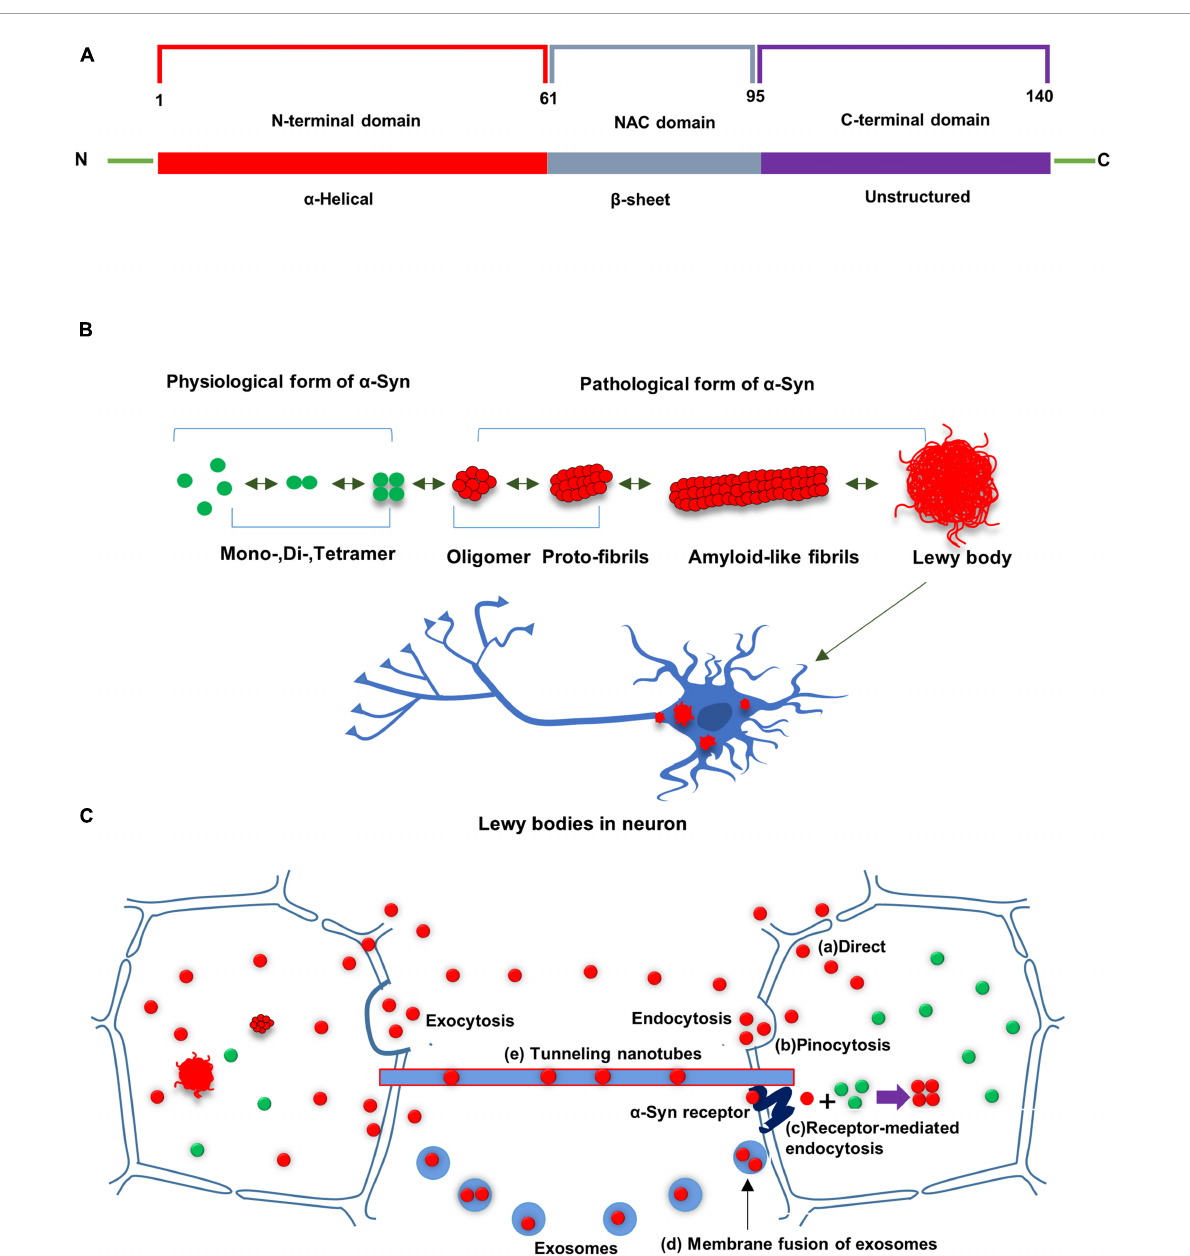
FIGURE1 (A) Schematic diagram of α -Syn. α -Syn consists of three distinctive domains: N terminal domain, non-amyloid component domain (NAC), and C-terminal domain. (B) Native α -Syn exists in the form of monomer, dimer and tetramer in a physiological state. α -Syn changes its conception under certain conditions to form unstable oligomers and fibrils, amyloid-like fibers, and finally form insoluble protein aggregates which deposit in neurons and cause neurotoxicity. (C) Possible routes for cell-to-cell transfer of misfolded α -Syn: Misfolded α -Syn are secreted from donor cells to the interstitial compartment as naked protein or in vesicles (e.g., exosomes). α -Syn could be taken up by neighboring cells in culture via several routes, including direct penetration of the plasma membrane, receptor-mediated endocytosis or fusion of plasma-exosomal membranes. Tunneling nanotubes have been also shown to transport misfolded α -Syn between cells. Misfolded α -Syn from the donor cell can seed conversion of native α -Syn into aggregated misfolded α -Syn in recipient